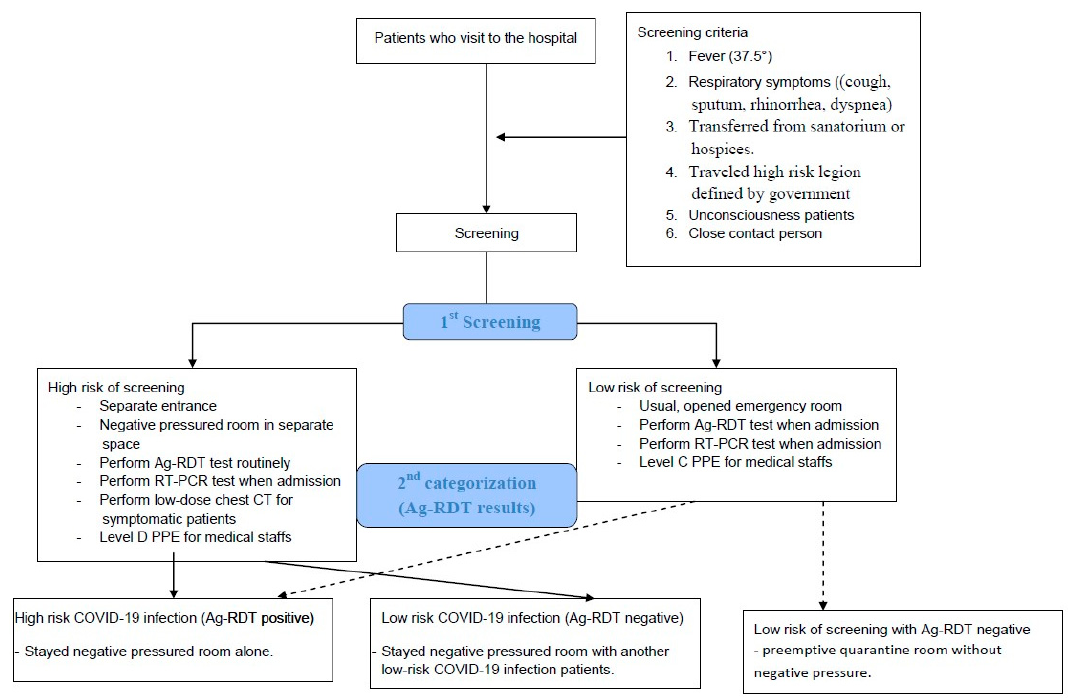
Figure 1. The admission protocol of our hospital.